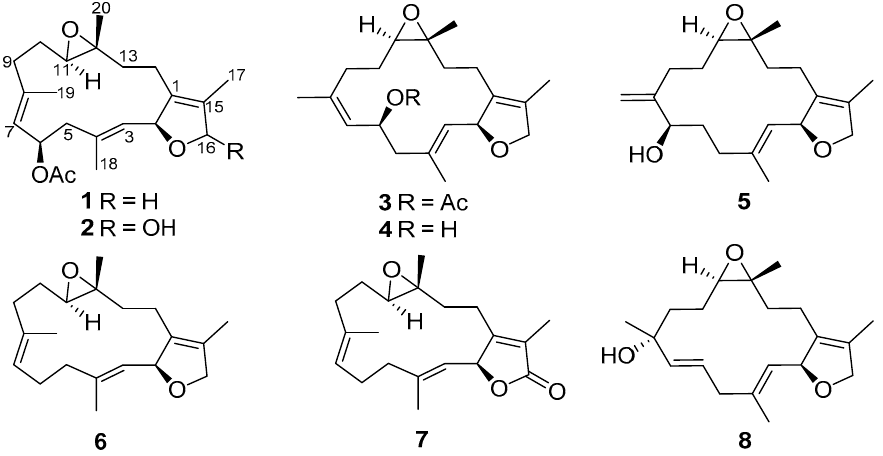
Figure 1. The structures of compounds 1 – 8 isolated from Sarcophyton ehrenbergi . Table 1. 1 H-NMR spectroscopic data of 1 – 5 in CD 3 COCD 3 (400 MHz, δ in ppm, J in Hz).